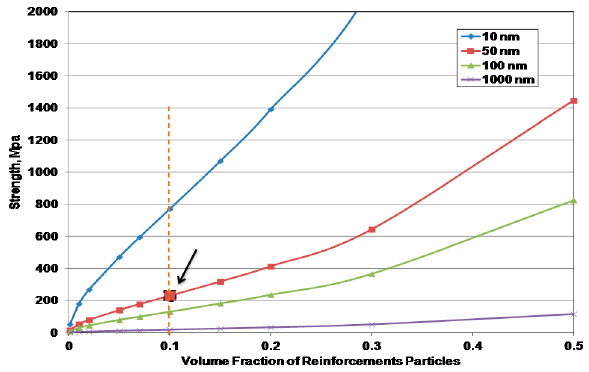
Figure 6. Theoretical strengthening effect of nano reinforcement addition. The arrow points to the theoretical strength level of Al ‐ SiC nanocomposite foam.